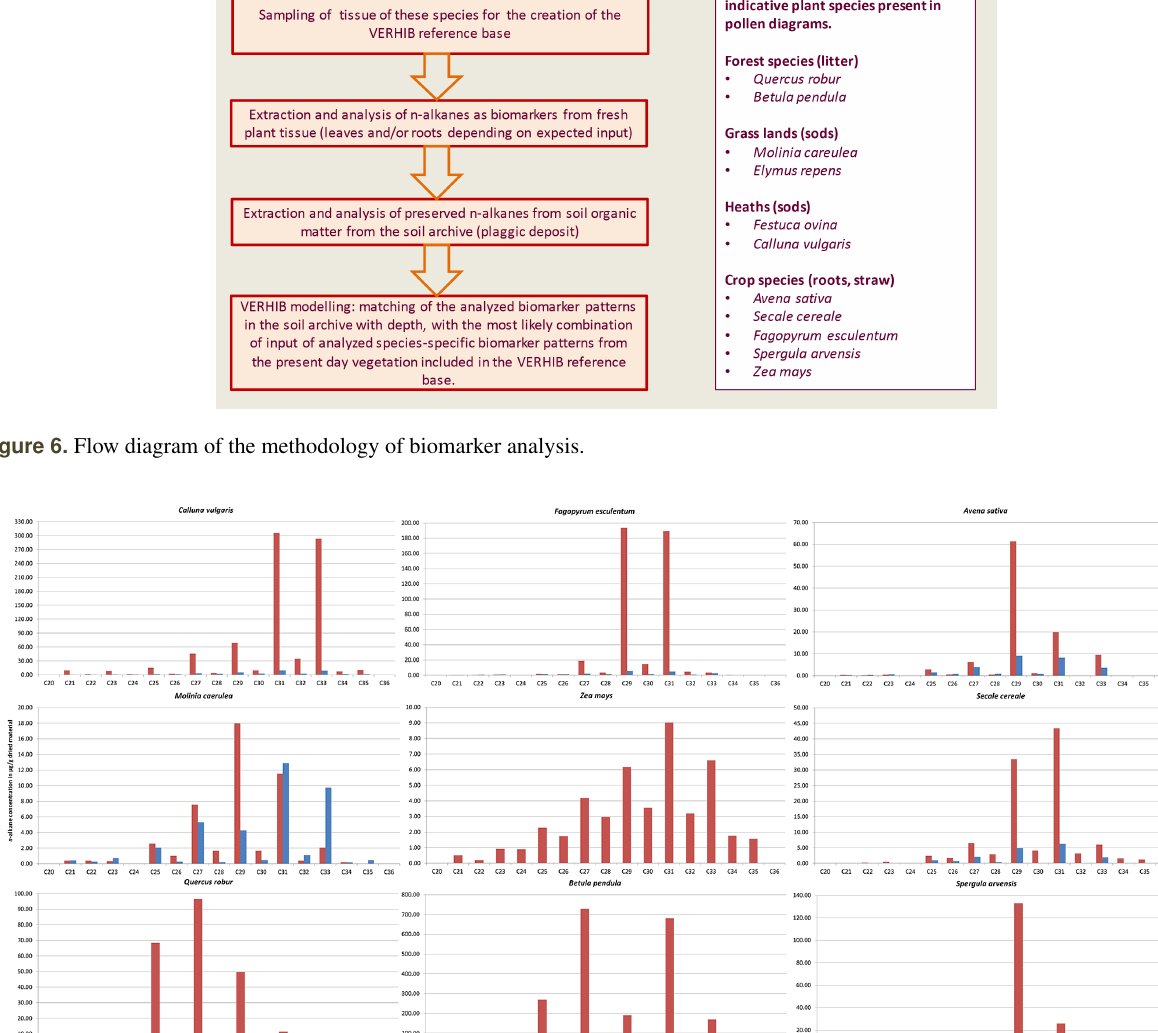
3 The vertical distribution of biomarkers and pollen in the analyzed